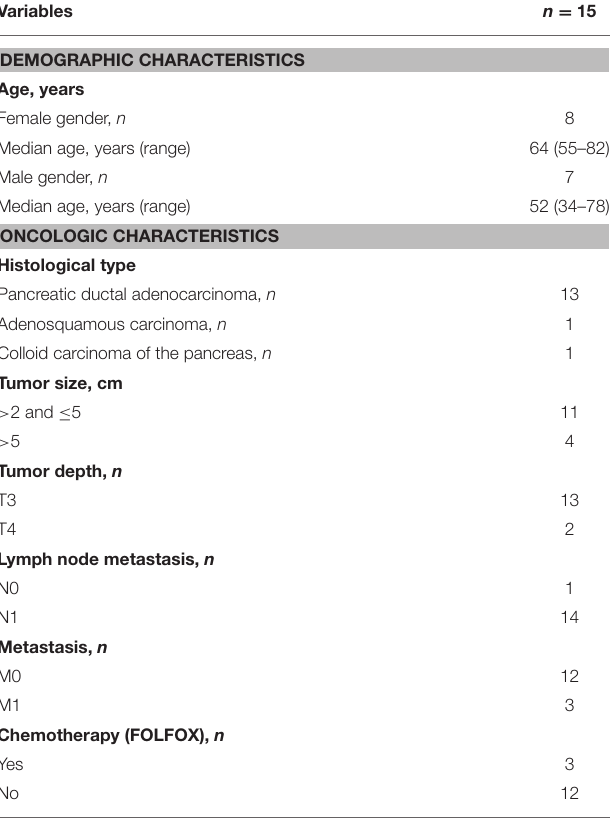
TABLE 1 | Patient